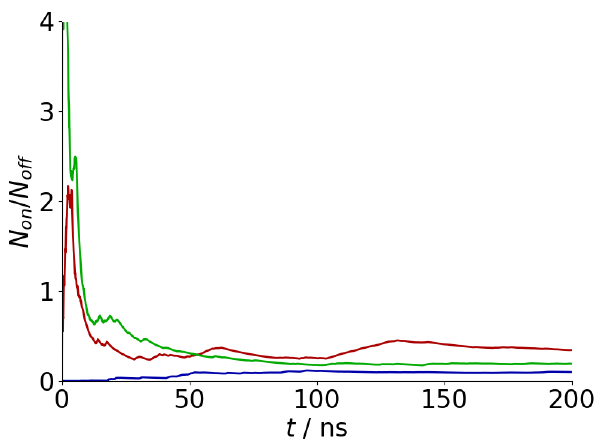
Figure A3. Ratio of adsorbed and desorbed conformations for REST simulations on Au100 (red), Ag111 (green), and Ag100 (blue)